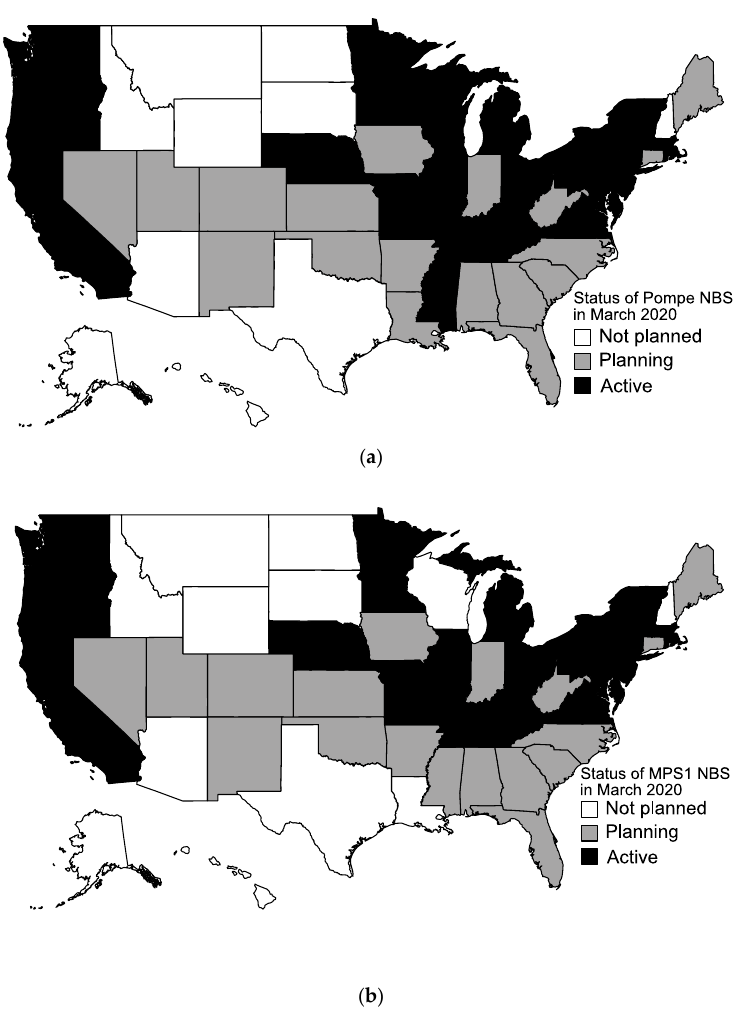
Figure 1. Map of current status of newborn screening (NBS) for Pompe disease and Mucopolysaccharidosis type I (MPSI) as of March 2020. ( a ) Active screening (black), planning stages (gray), and no screening planned (white) for Pompe disease; ( b ) Active screening (black), planning stages (gray), and no screening planned (white) for